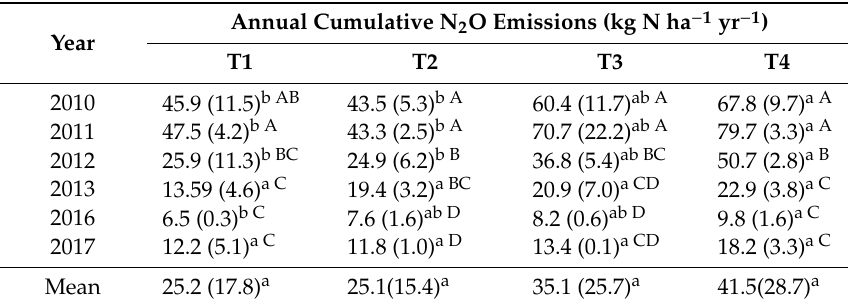
Table 6. Annual cumulative N 2 O emissions for each treatment.